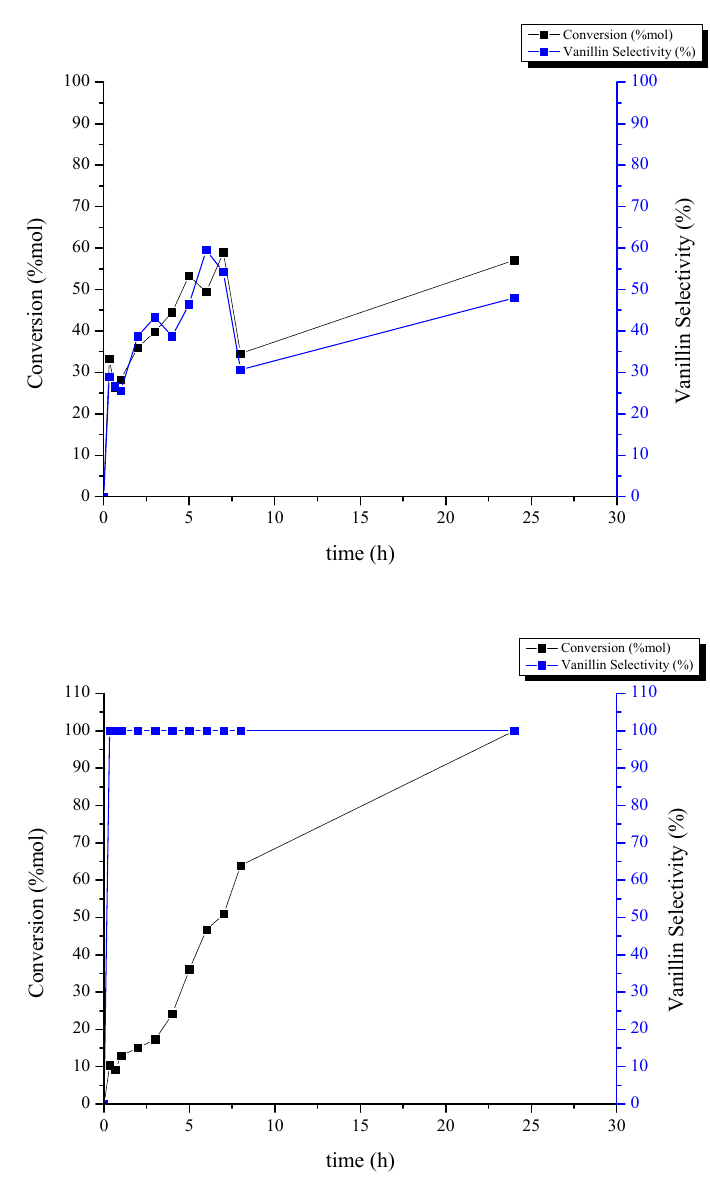
Figure 9. Catalytic activity at 40 °C of CuO/MgFe 2 O 4 catalyst in the oxidation of isoeugenol to vanillin ( top image ) and CuO/MgFe 2 O 4 catalyst in the oxidation of vanillyl alcohol to vanillin ( bottom image ).